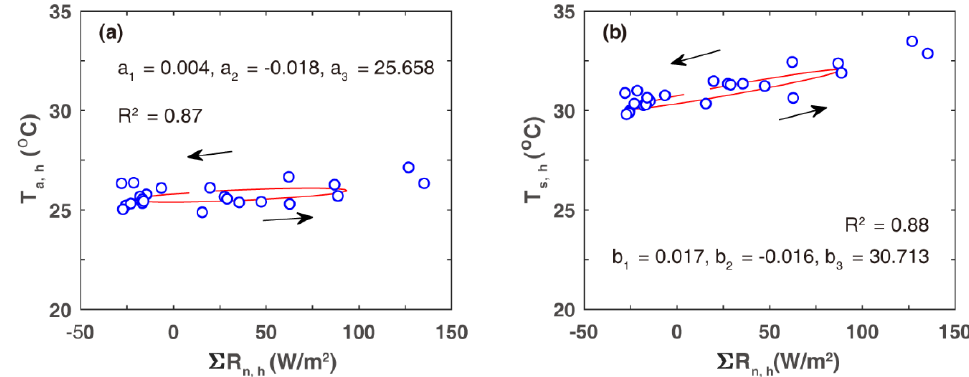
Figure 11. Lag effect between R n,h and T h on August 5. ( a ) R n,h and T a, h ; ( b ) R n,h and T s, h . Table 1. Regressed coefficients characterizing temperature-radiation lag effect of the grassland.